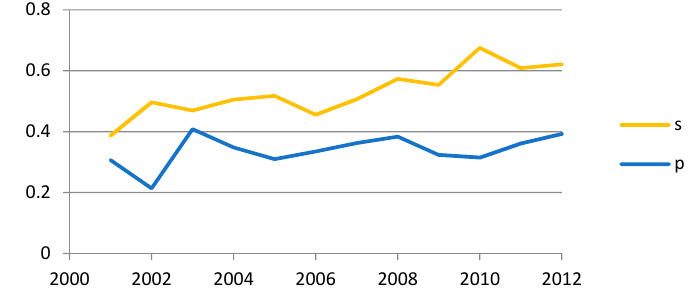
Figure 1. Literature coverage of surgical (s) versus prosthodontic (p) issues: x-axis indicates year of publication, y-axis indicates the ratio of numbers of publications (surgical/prosthodontic) to the total number of publications per year.